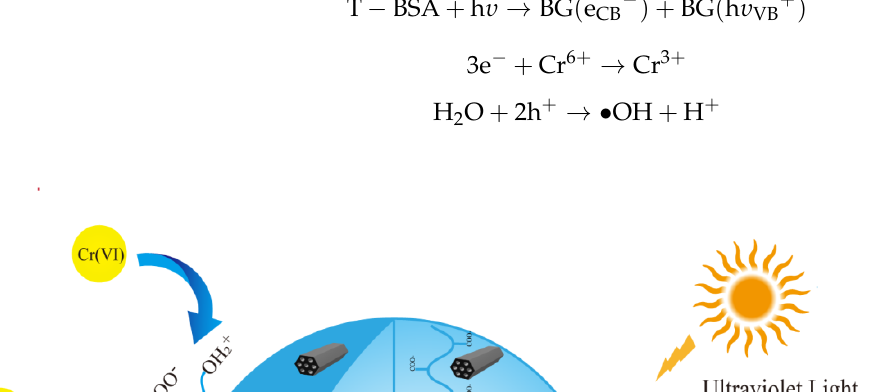
Figure 12. ( a ) UV-DRS spectra of SA, GTSA, and T-BSA; ( b ) photoluminescence spectra of SA, GTSA, and T-BSA.